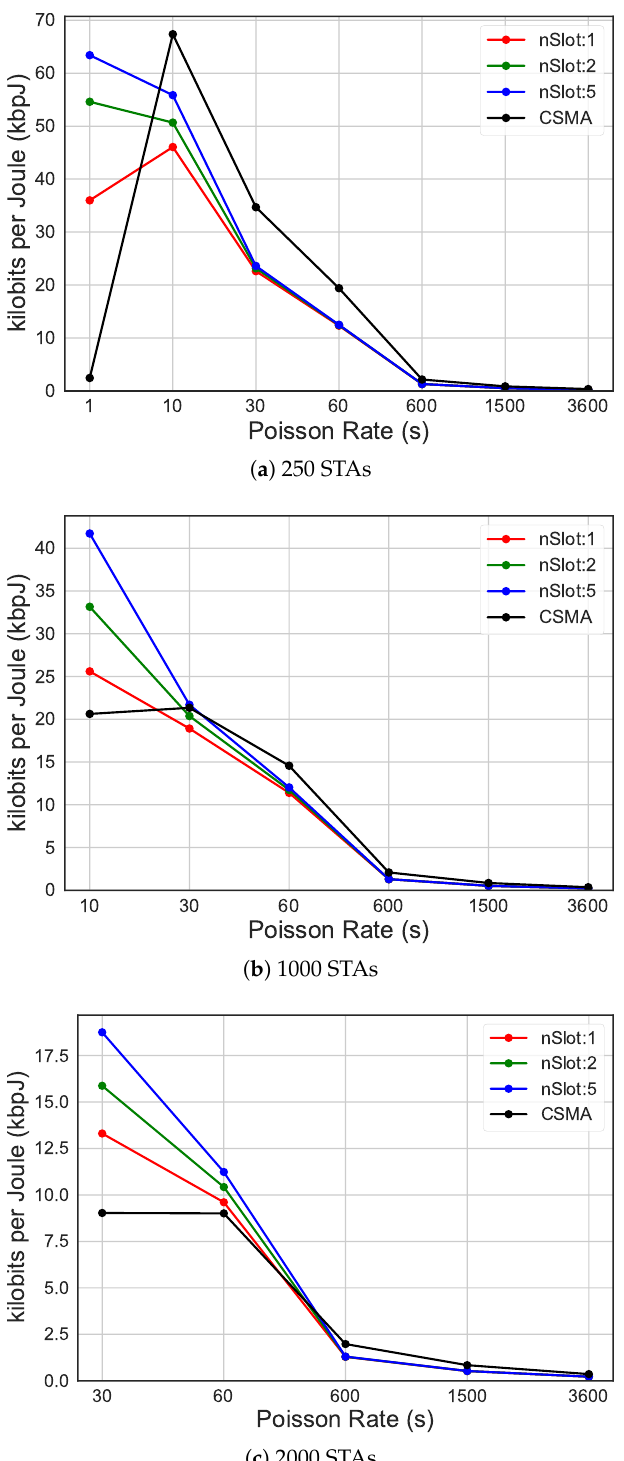
Figure 10. Energy efficiency of different traffic rates, comparing CSMA/CA and the usage of 10 RAW groups and 1, 2 and 5 slot per